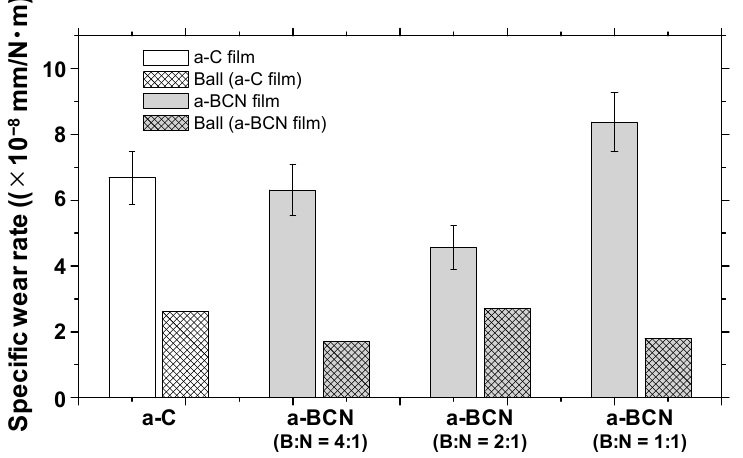
Figure 11. Specific wear rates of a-BCN and a-C films.